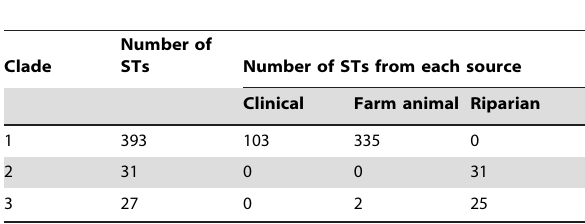
Table 1. Genotypic diversity of C. coli clades from different sources.